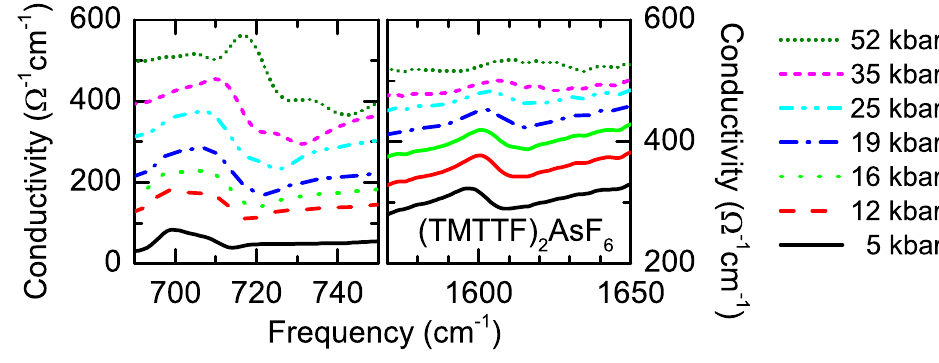
Figure 18. Pressure dependence of the optical conductivity of (TMTTF) at room temperature for E (cid:107) a . The 700 cm − 1 mode is related to the AsF − while the 1600 cm − 1 peak is related to the asymmetric C = C stretching vibration of the TMTTF